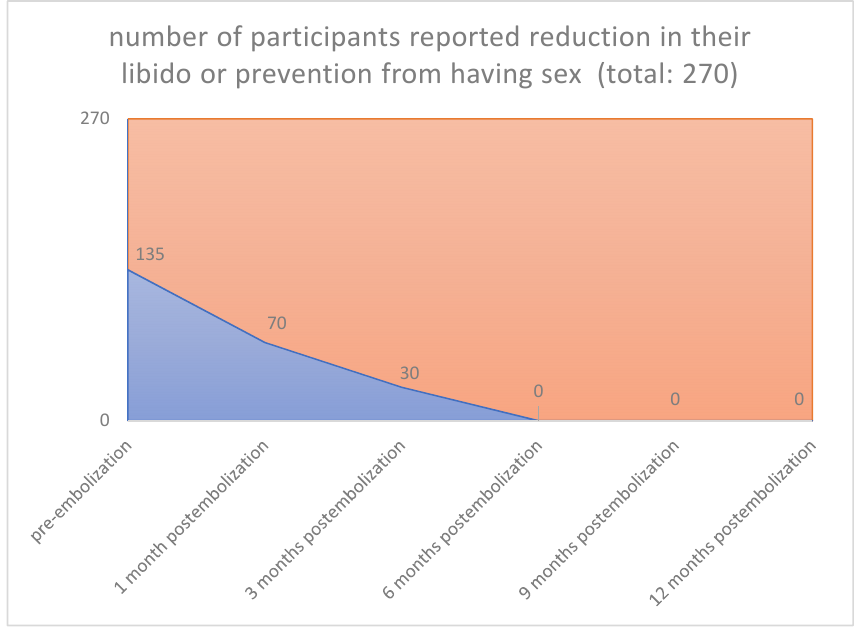
Figure 10. Libido: Pre-embolization 135 from 270 participants reported reduction in their libido or prevention from having sex. 1 Month 70 from 135 participants reported reduction in their libido or prevention from having sex. 3 Months 30 from 135 participants reported reduction in their libido or prevention from having sex. 6 Months 0 from 135 participants reported reduction in their libido or prevention from having sex . 9 Months 0 from 135 participants reported reduction in their libido or pre-vention from having sex. 12 Months 0 from 135 participants reported reduc- tion in their libido or prevention from having sex.